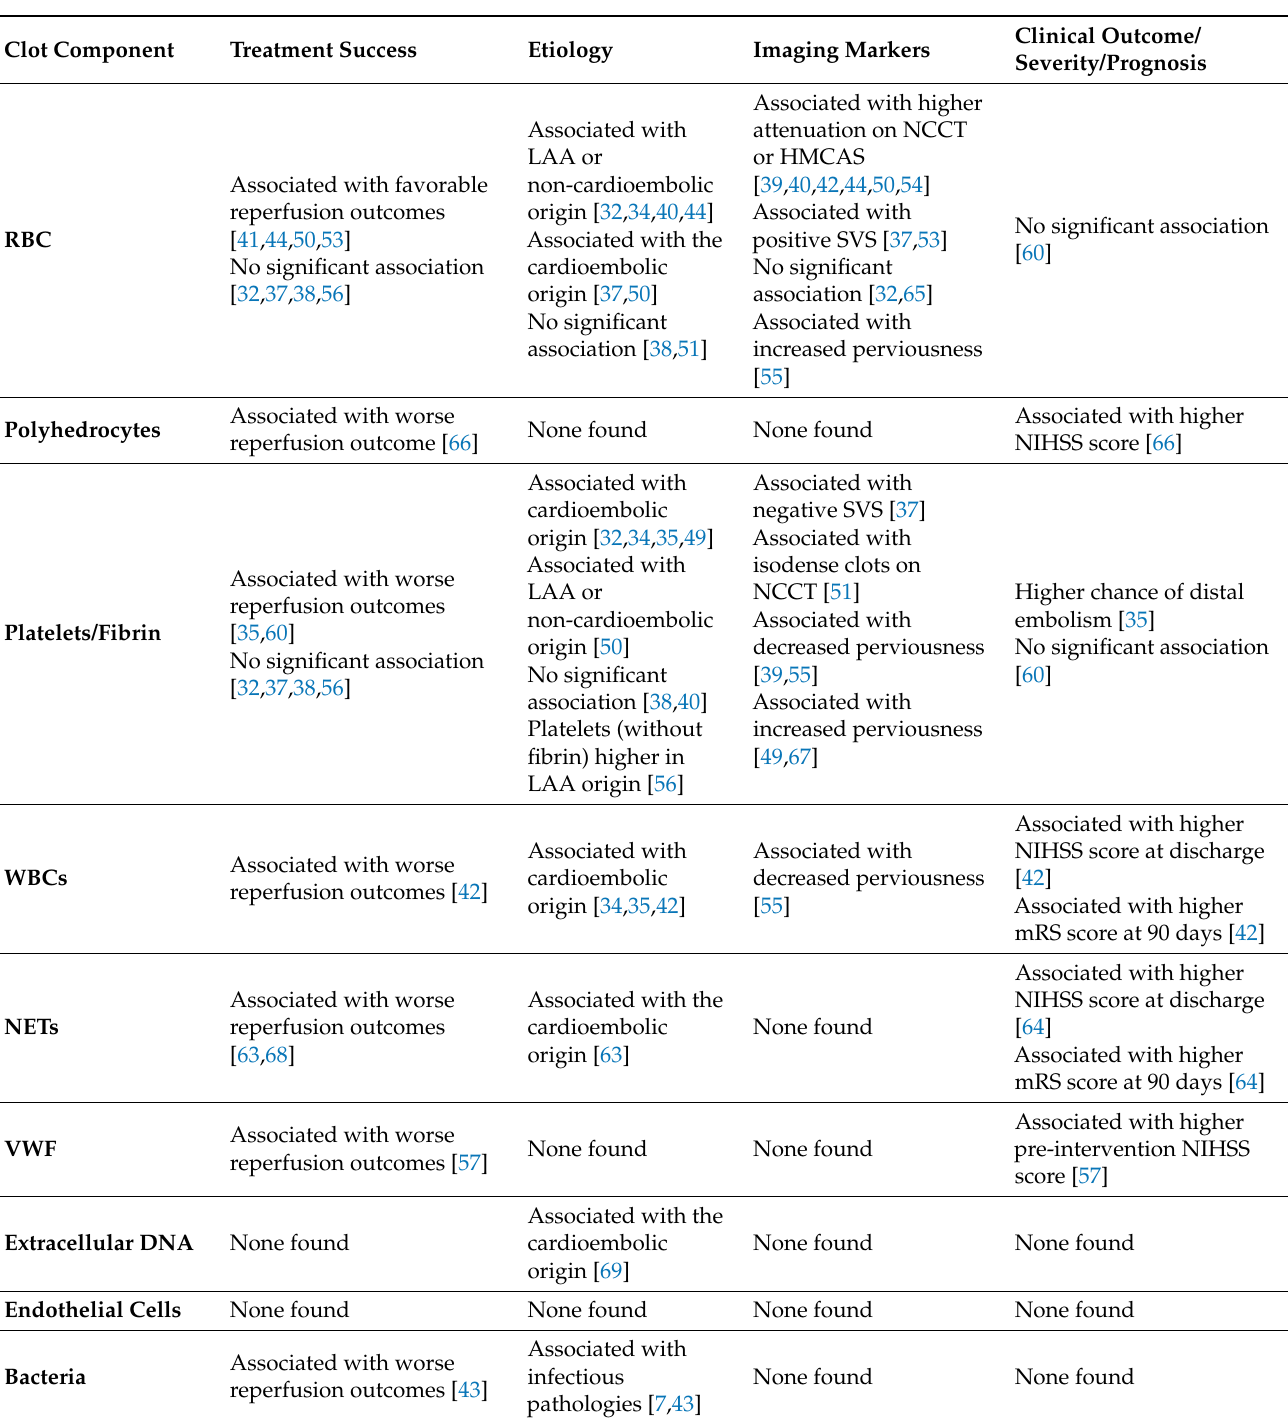
Table 2. Associations between thrombus components and stroke treatment success, etiology, imaging, and clinical